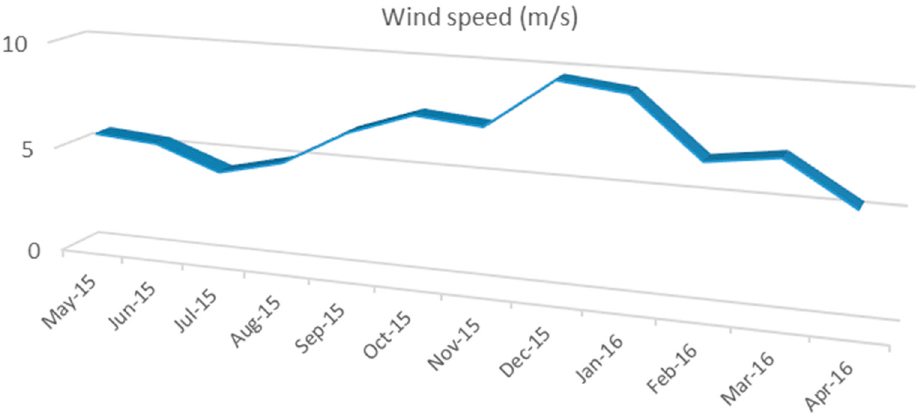
Figure 8. Mean monthly wind speed.